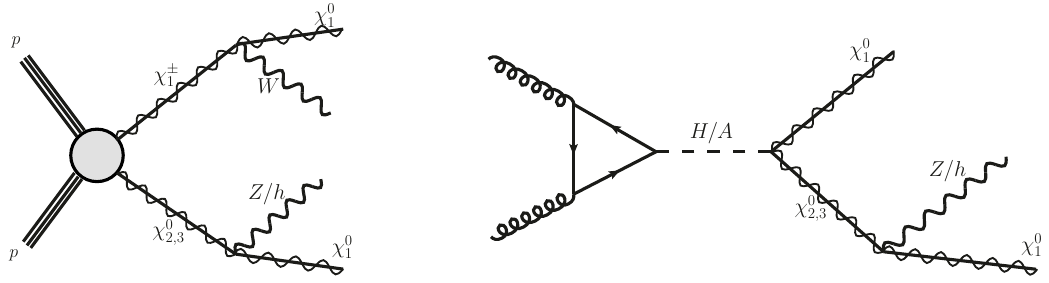
Figure 1 . Representative decay topologies of electroweakino production at the LHC. Left: di- rect production channels resulting from pair producing a chargino and neutralino. Right: the Higgs portal channel resulting from the production of a heavy neutral Higgs boson decaying to neutralino